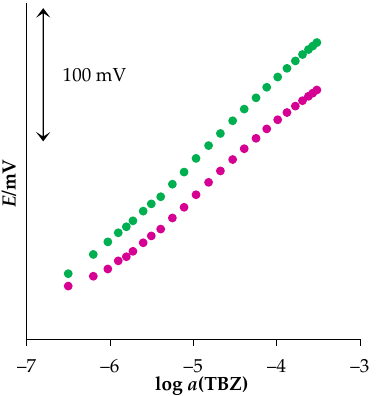
Figure 6. Responses of the new MWCNT-OSO 3 − TBZ + sensor to TBZ in water ( ● new sensor, ● after approximately three months with daily measurements).